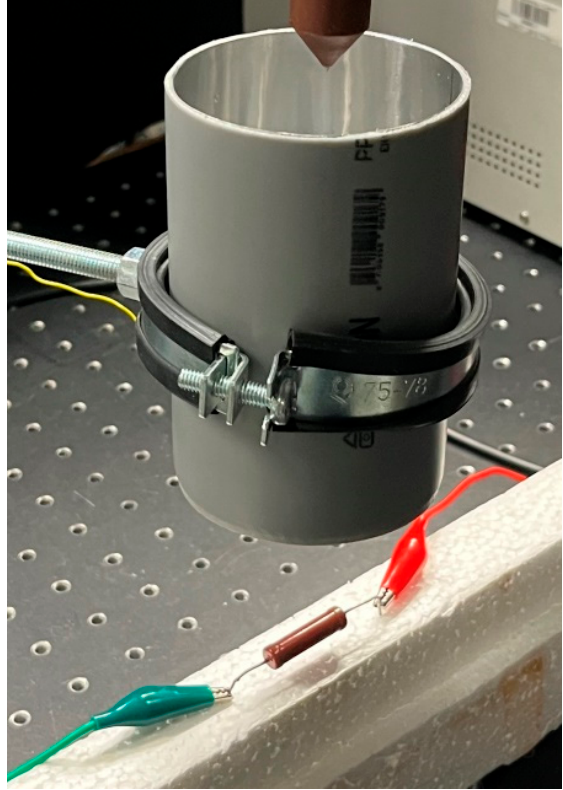
Figure 11. Experimental setup of power resistor cooled by EHD airflow generator.